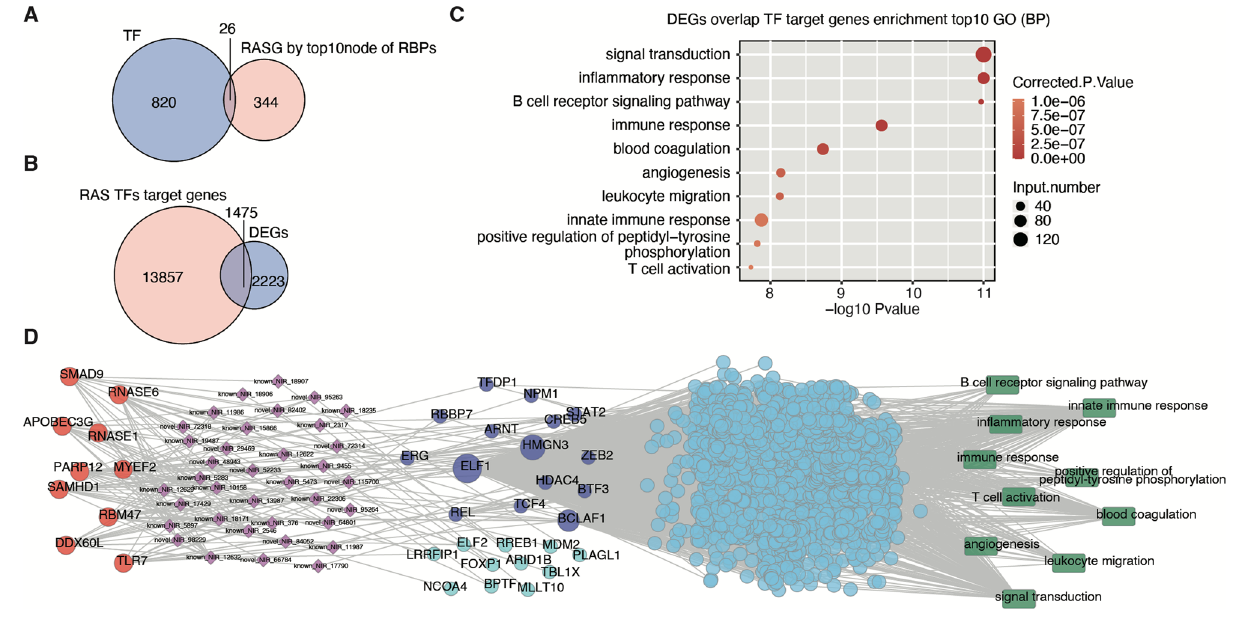
Figure 4. RNA-binding proteins (RBPs) regulate the alternative splicing (AS) of transcription factors (TFs), and differentially expressed target genes of transcription factors (TFs) are enriched in immune and inflammation- related pathways. ( A ) Venn diagram showing TFs and simultaneous deregulation of AS event (ASE) genes, p -value = 1 ( B ) Venn diagram showing the overlapping differentially expressed genes (DEGs) and the predicted TF (as shown in Fig. 4A) targets in the Gene Transcription Regulation Database (GTRD; http:// gtrd. biouml. org/). The TFs were identified in the GTRD, p -value = 1. C The 10 most enriched GO terms as determined by overlapping target mRNAs of the TFs are shown in Fig. 4B. D The simultaneous deregulation of the AS network by the 10 most enriched RBPs (the far left part) and RASEs of TFs (the middle left part). The 10 GO terms most enriched with differentially expressed target genes of TFs (the middle right part) are shown in